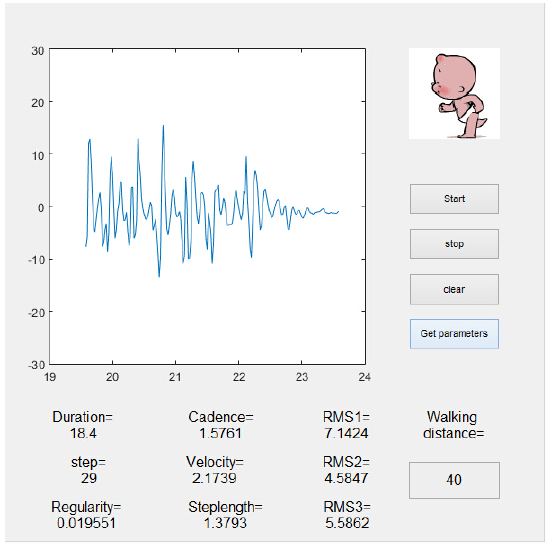
Figure 4: Matlab GUI